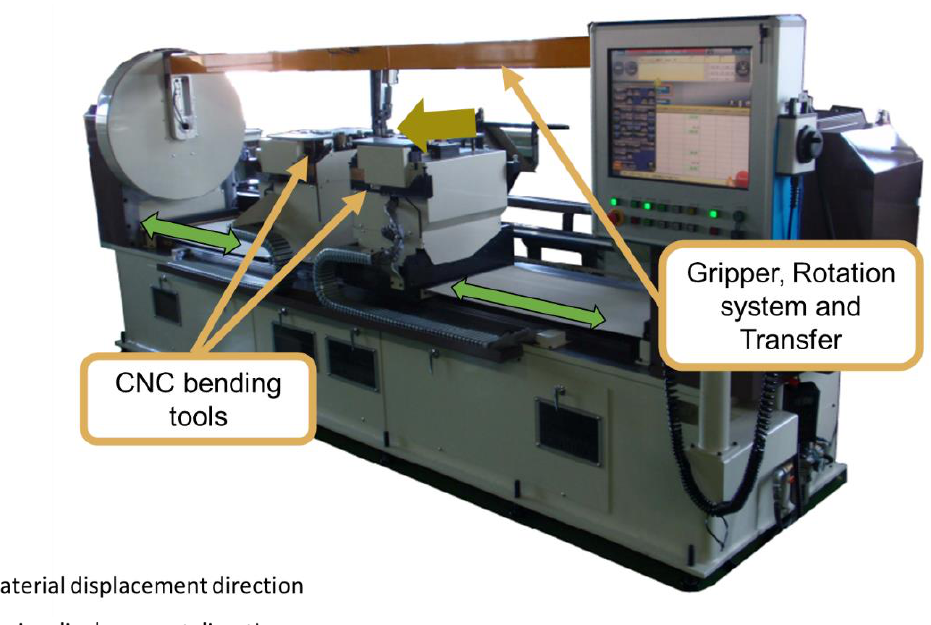
Figure 9. Wire-bending equipment TWF-C07 A D.